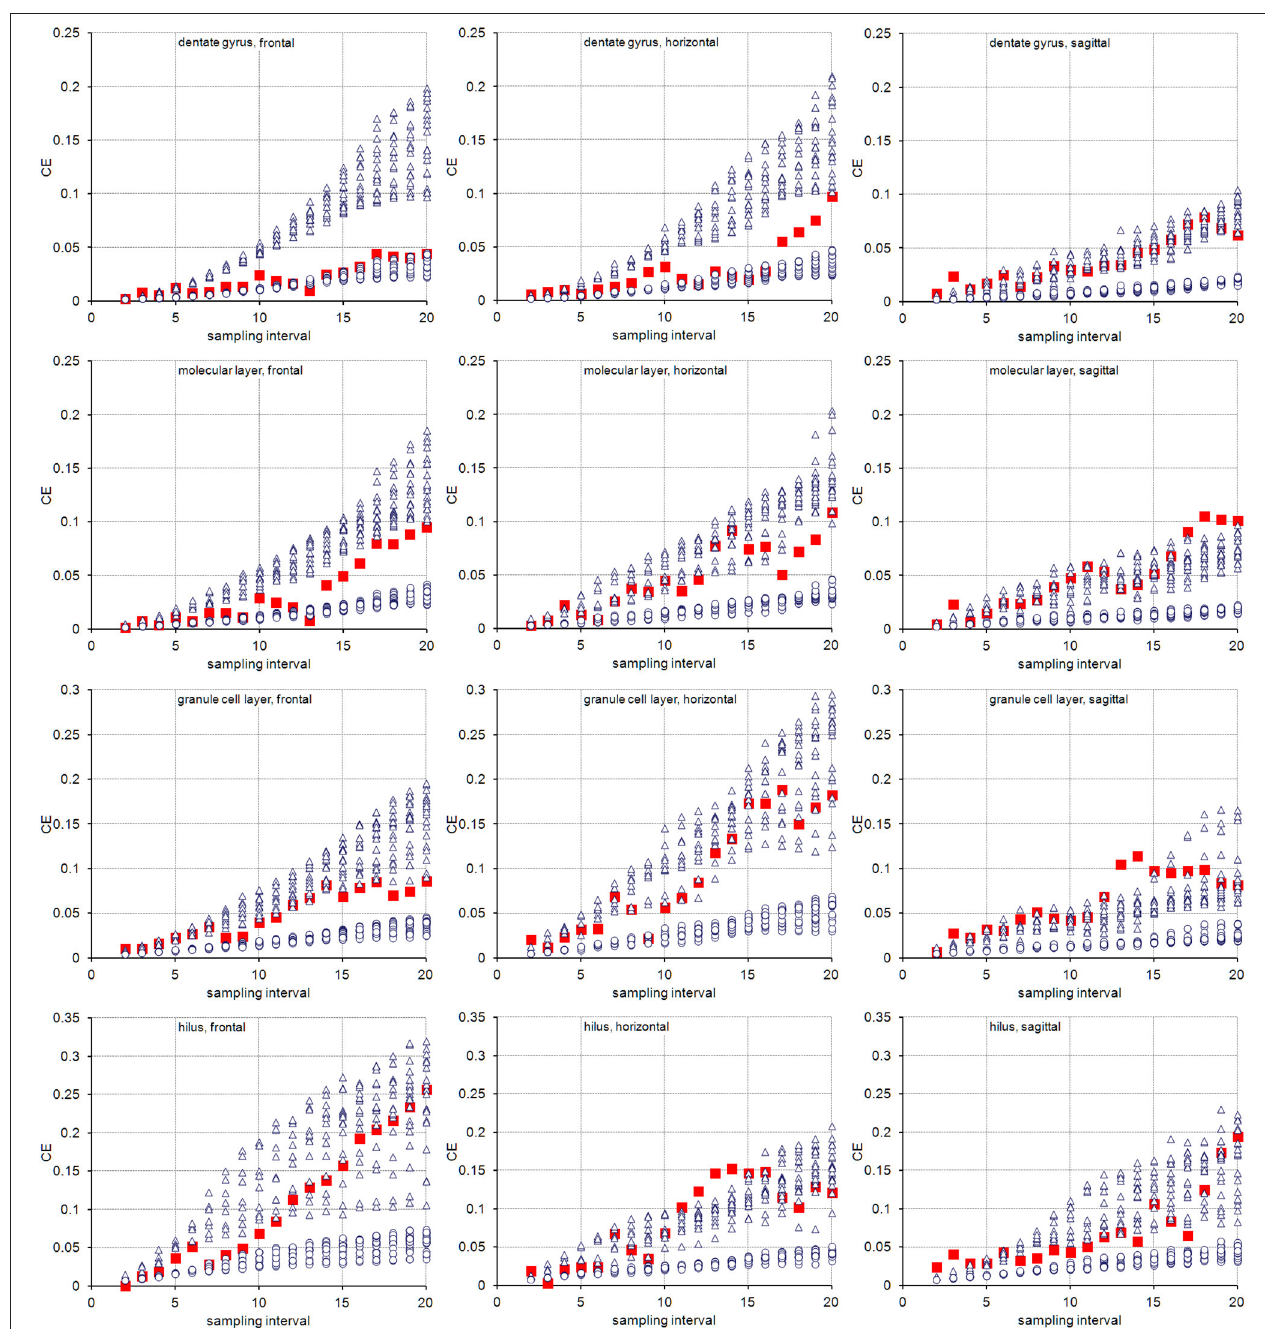
FIGURE 3 | Measurement precision vs. sampling frequency. CE s are plotted for increasing intervals between the sampled sections. Empirical estimates of the CE s (filled squares) are typically bounded by Gundersen-Jensen CE estimates for m 0 (open triangles) and m 1 (open circles). Sampling intervals at which the = = empirical CE exceeds the range of estimated CE s correspond to intervals between peaks in the volume distributions of the layers ( Figure 2 ). How many sections will be analyzed depends on the size of the structure of interest along the direction of the cutting. E.g., about 110 frontal 20 µ m thick sections would contain the granule cell layer (see Figure 2 ). Series sampled using an interval of 10, i.e., every 10th section is collected (200 µ m between sections), would contain 11 sections to be analyzed. If sections are cut, e.g., 40 µ m thick, a series of every 5th section (200 µ m between sections) would generate a similar number of sections.